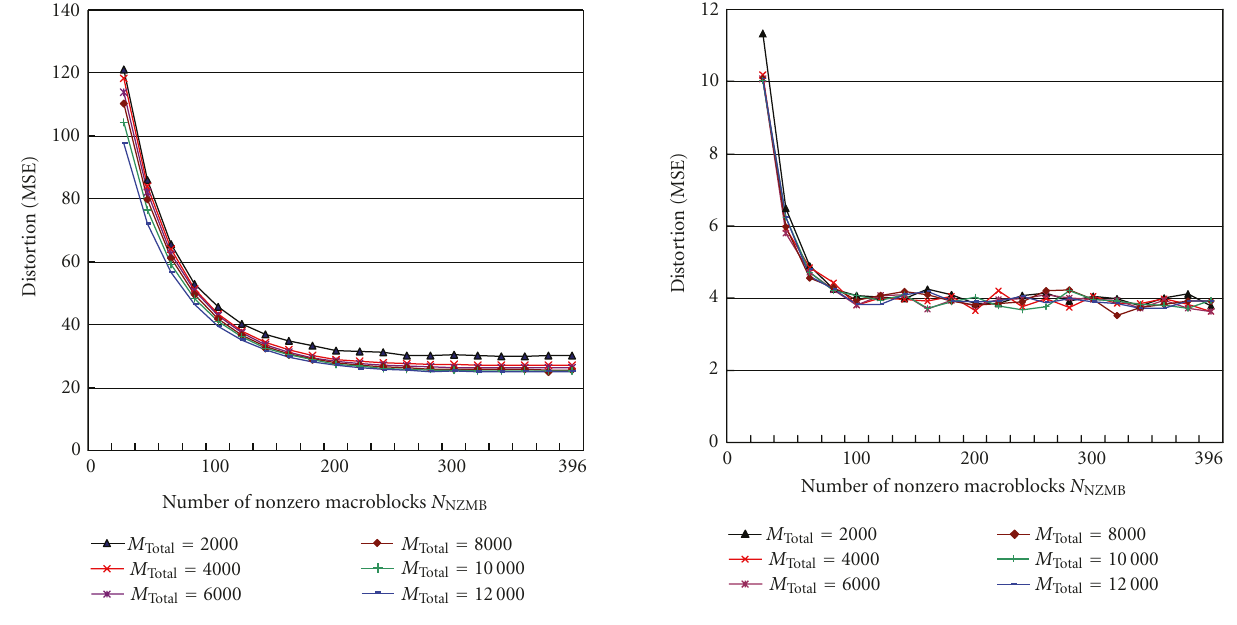
macroblocks with larger residual. After motion estimation, the residuals of the macroblocks are sorted in a descending order. The first N NZMB macroblocks are coded as nonzero macroblocks while the remaining macroblocks are treated as all-zero macroblocks.